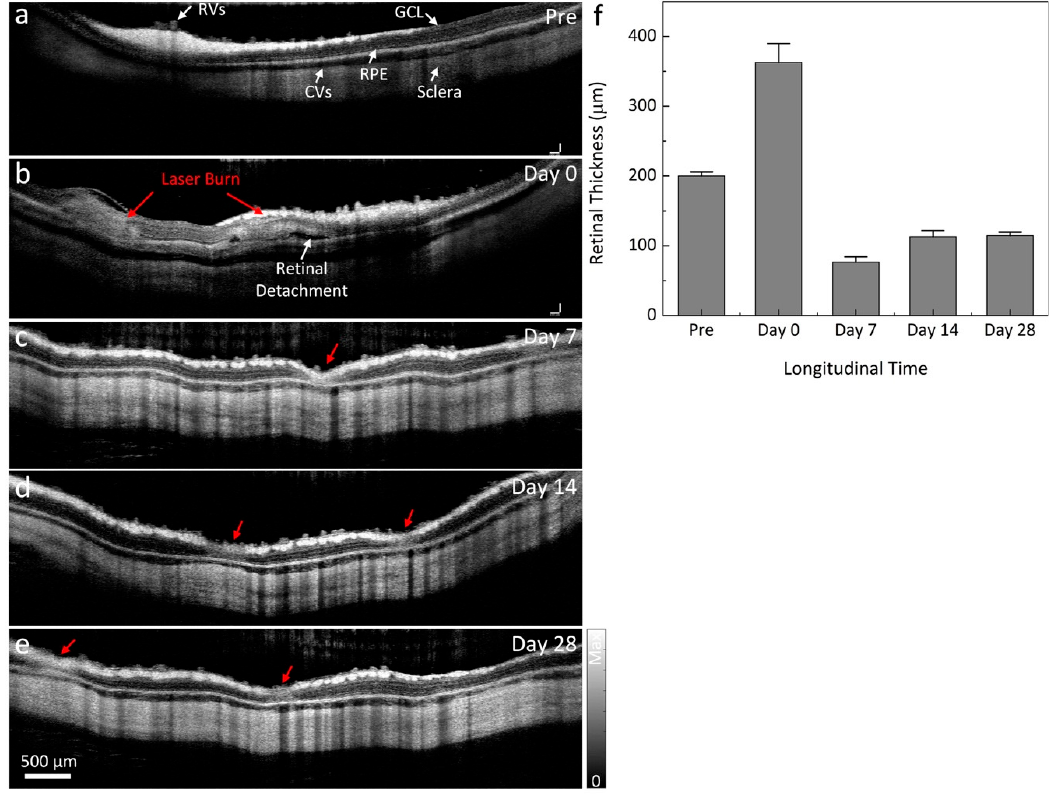
Figure 2. Optical coherence tomography (OCT) visualization of CVO. ( a ) B-scan OCT images acquired along the selected blue scanning line from ( a ). This image demonstrates retinal vessels (RVs), choroidal vessels (CVs), the ganglion cell layer (GCL), retinal pigment epithelium (RPE), and sclera. These layers are intact. ( b – e ) Two dimensional (2D) cross-sectional OCT images acquired after laser illumination. Retinal detachment appeared after CVO (white arrow). The normal retinal morphology is dramatically altered at the laser injury sites (red arrows). ( f ) Graph of the measured retinal thickness profile from the laser injury sites. This shows the dynamic changes of retinal thickness over time.